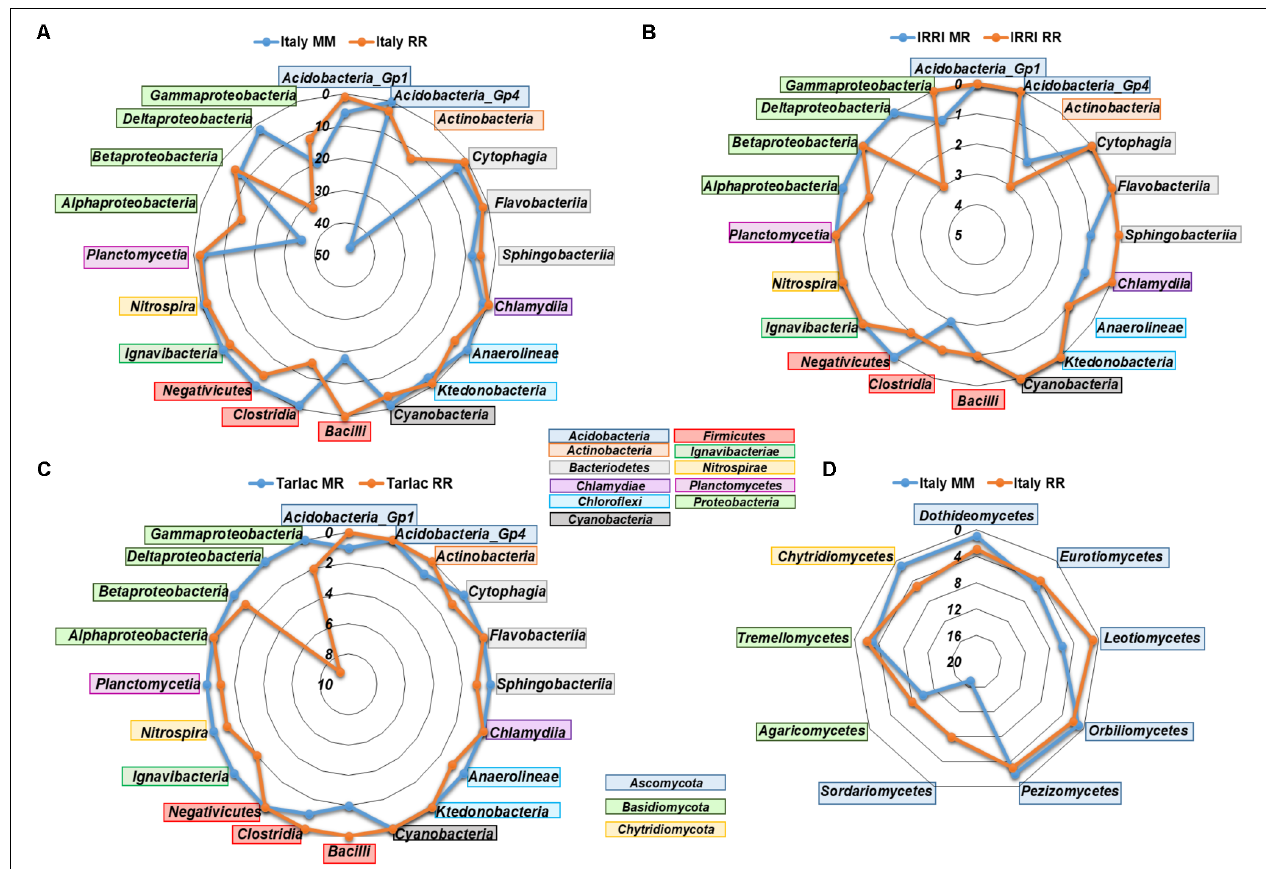
FIGURE 4 | Radar charts showing the number of bacterial (A–C) and fungal (D) genera in different classes that were identified as significantly enriched by crop rotation in the different field locations (Italy, IRRI, Tarlac) based on STAMP analysis. Displayed are classes for which at least three different genera were identified as specifically enriched in one or the other soil. Fungal responses to crop rotation at IRRI and Tarlac were weak and are therefore not included in the figure.